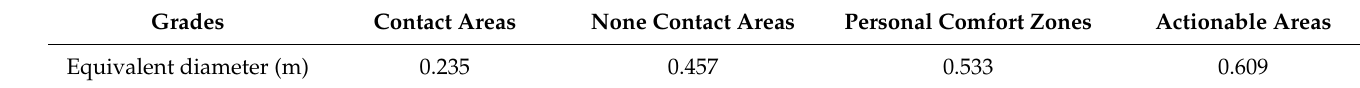
Table 2. Classification of pedestrian static